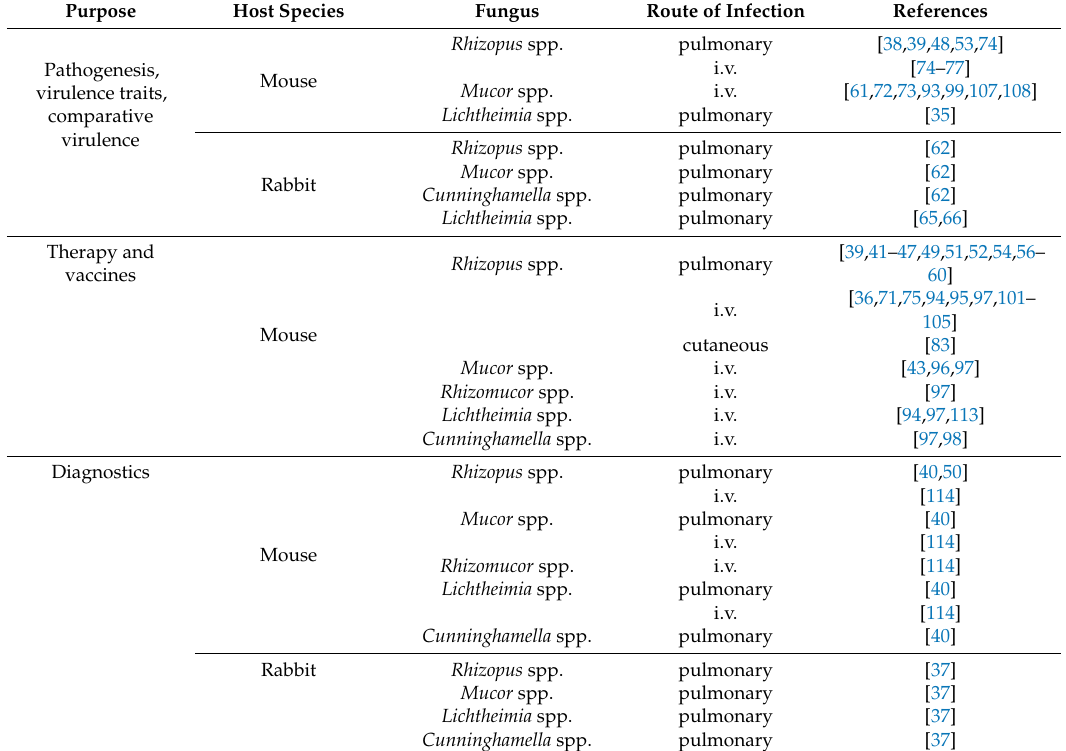
Table 3. The application of animal models in mucormycosis research 1